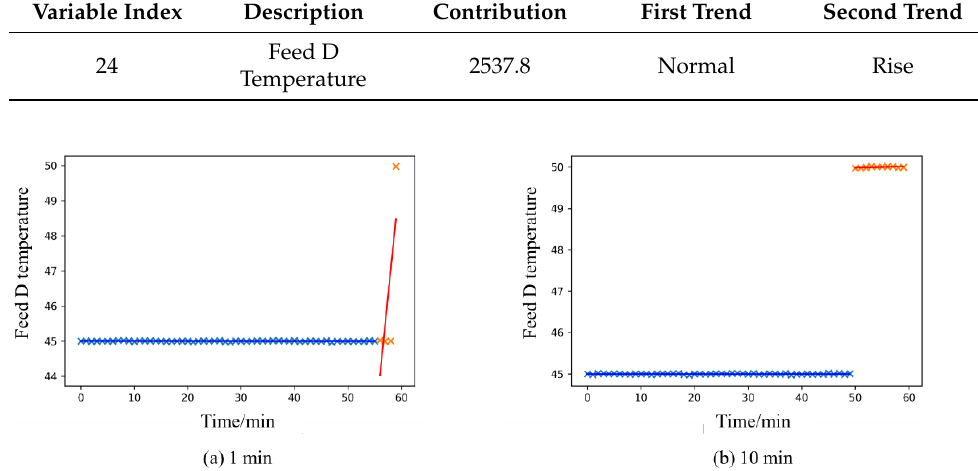
Table 4. The contributions of abnormal variables in 1 min for Mode 2 fault 3.